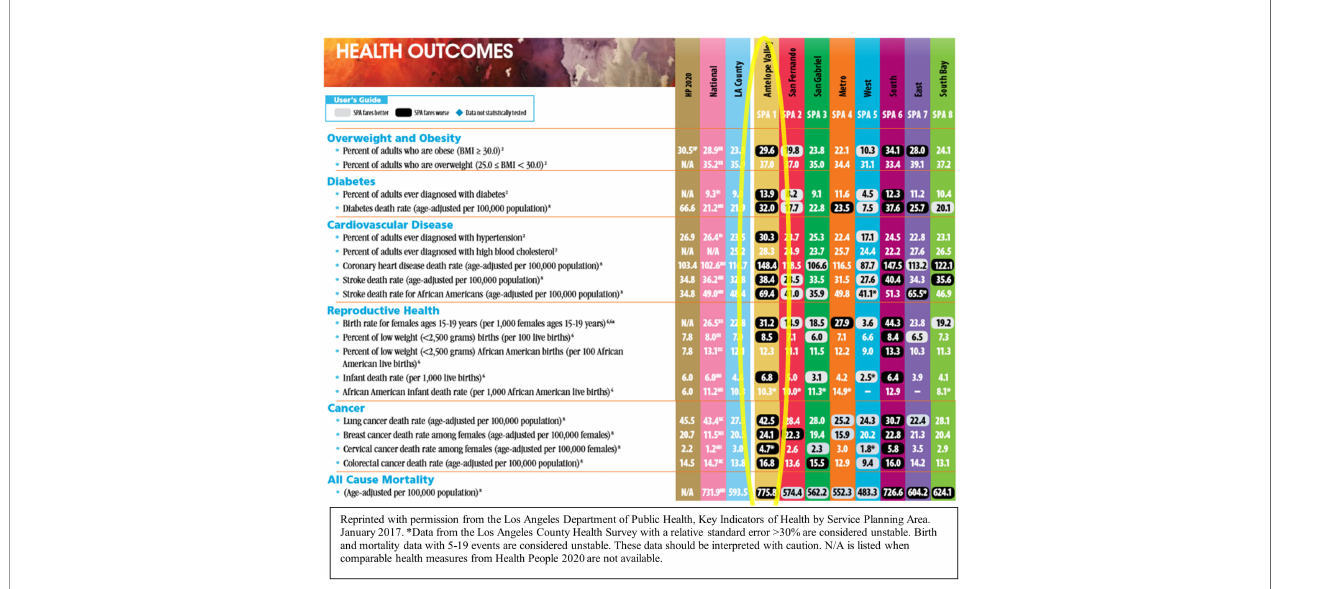
FIGURE 1 | Los Angeles Department of Public Health, Key Indicators of Health by Service Planning